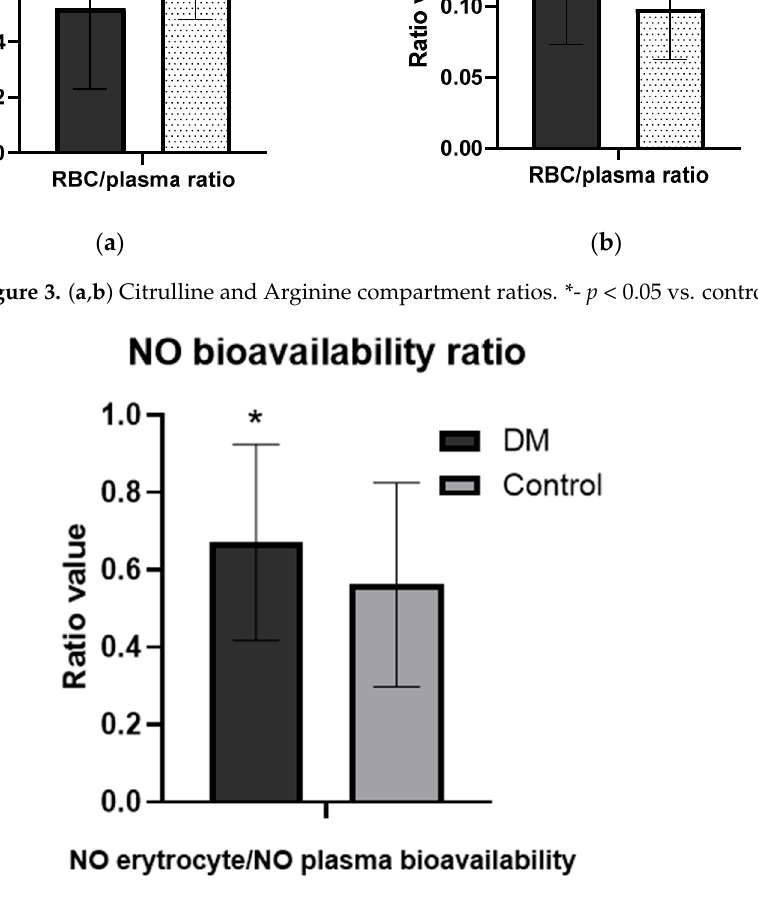
Figure 4. Nitric oxide (NO) bioavailability ratio. *- p < 0.05 vs. control. Table 3. The Nitric oxide pathway metabolites